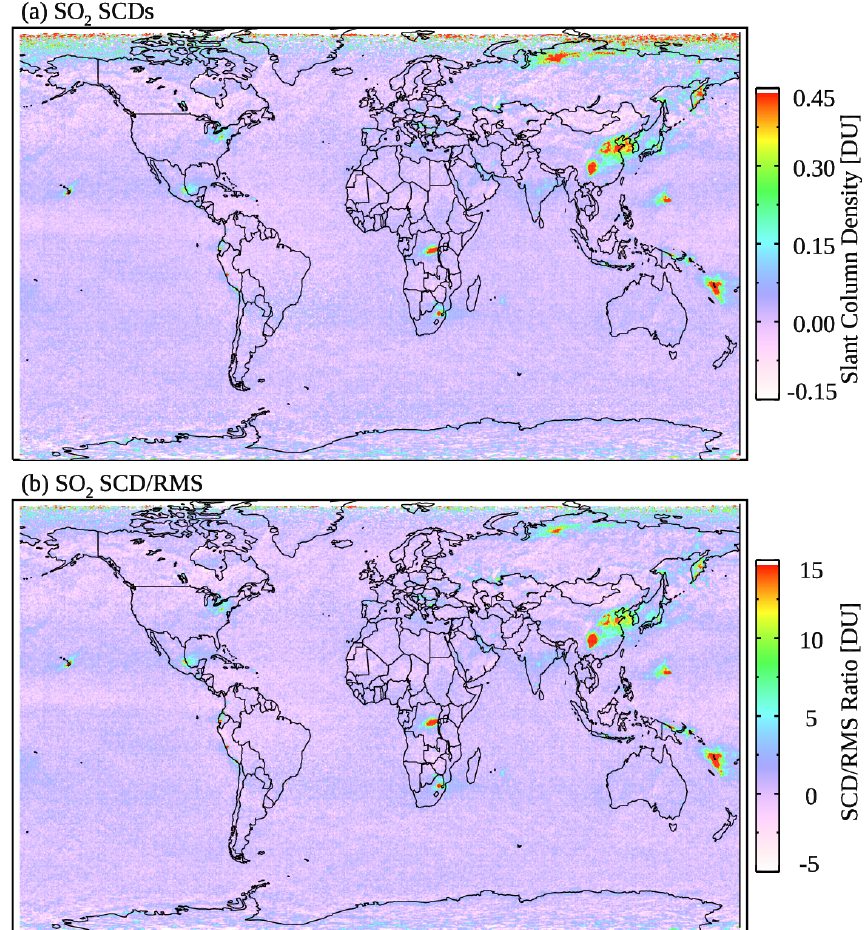
Figure 2. (a) Monthly mean OMI SO 2 SCDs for March 2005 showing enhanced SO 2 signals over major anthropogenic source areas (e.g., China, the eastern US, India, and South America) as well as degassing volcanoes. Note the positive bias at northern high latitudes. (b) Monthly mean SCD / rms ratio (SRR) from the same sample of OMI pixels as in panel (a) . The SRR map also shows major SO 2 sources but has reduced bias at high latitudes compared with the SCD